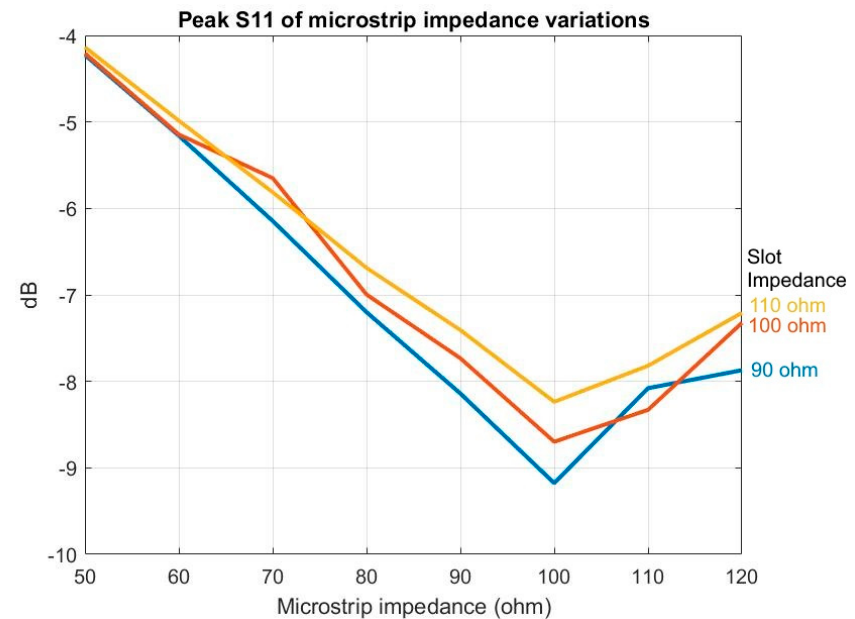
Figure 3. Peak S11 of variances of microstrip impedance (blue: 90- Ω slot impedance, red: 100- Ω slot impedance, and yellow: 110- Ω slot impedance).